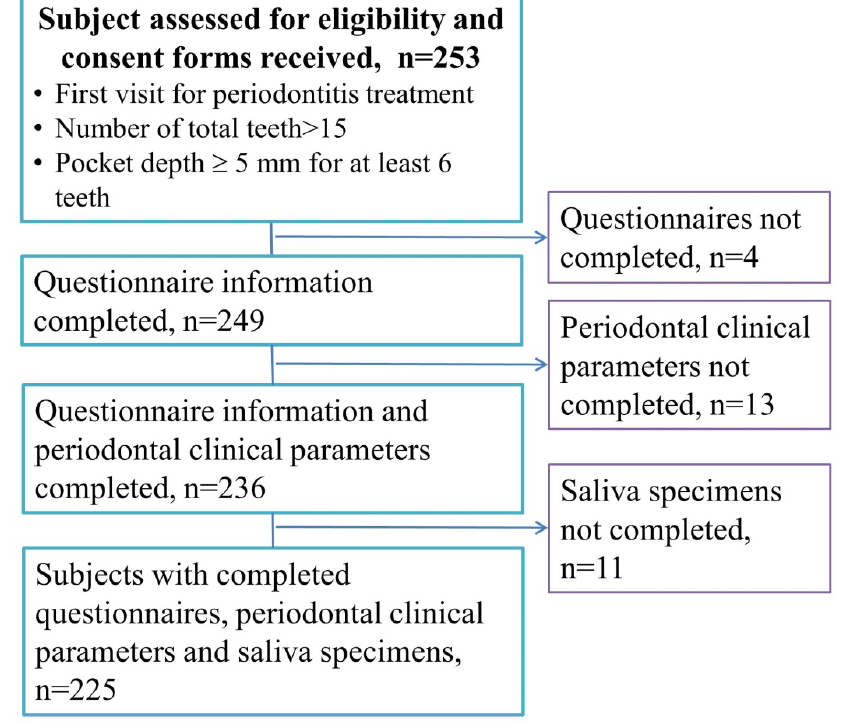
Figure 1. Flowchart of the participant enrollment.